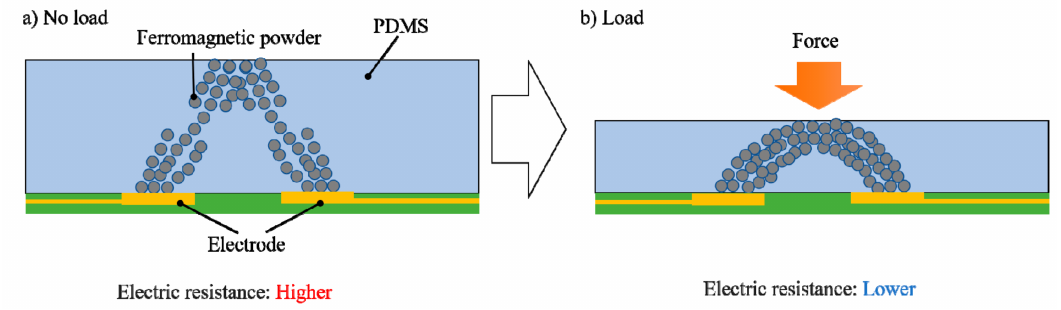
Figure 3. The principle of resistance measurement on soft-MPS for: ( a ) initial condition; ( b ) load condition.